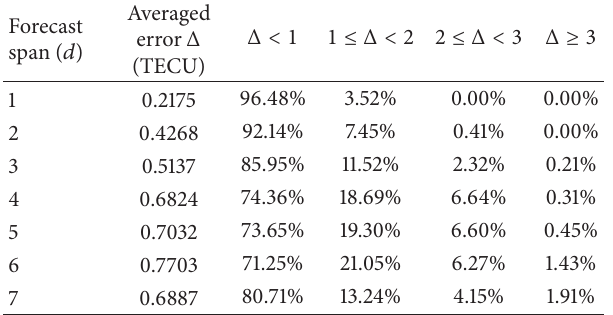
Table 3: Statistics of forecasting precisions of different time scales by direct